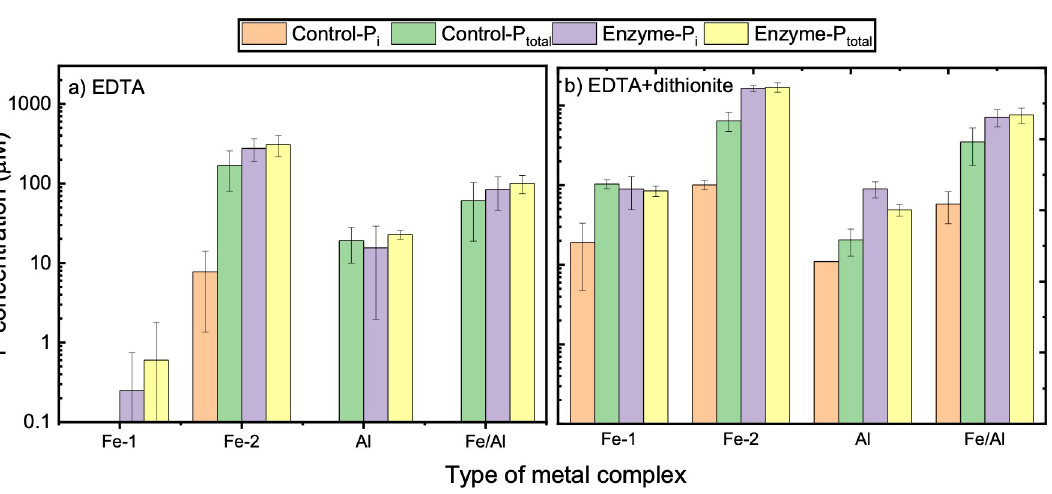
Fig 7. Effect of EDTA and dithionite on the dissociation of metal-phytate complexes (starting concentration of 2 mM P) at pH 5.0. (a) Incubation for 20 h in the presence of EDTA (5 mM); (b) Incubation for an additional 20 h after spiking with sodium dithionite (10 mM). Aspergillus phytase enzyme (0.1 U/mL) was used for the